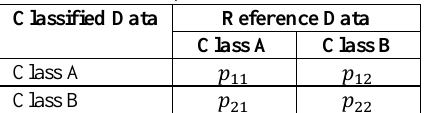
Table 1. The sample of onfusion matrix